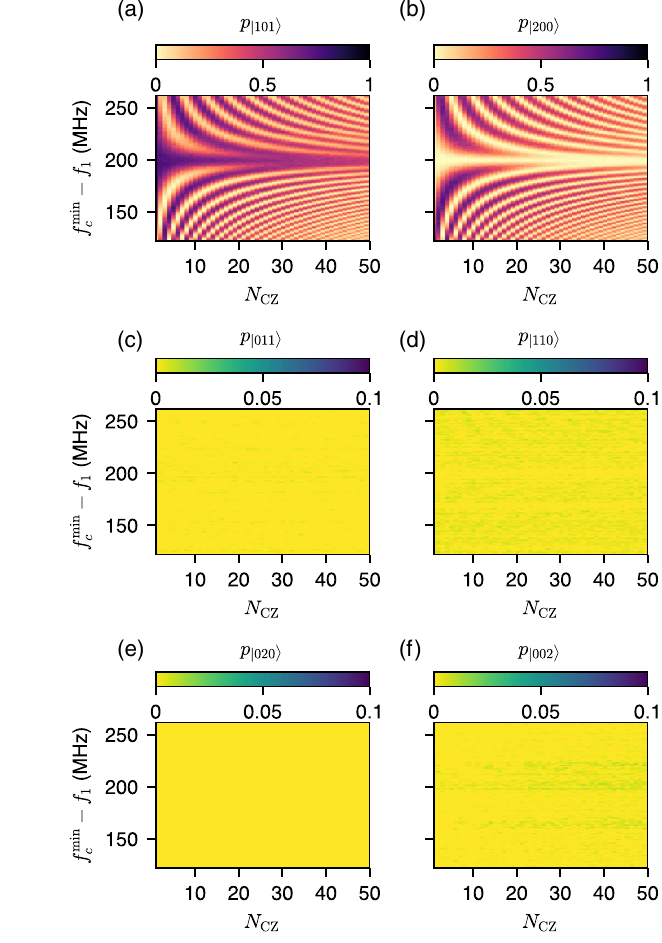
FIG. 38. State population of (a) j 101 i , (b) j 200 i , (c) j 011 i , FIG. 39. State population of (a) j 101 i , (b) j 200 i , (c) j 011 i , (d) j 110 i , (e) j 020 i , and (f) j 002 i for the repeated optimal CZ